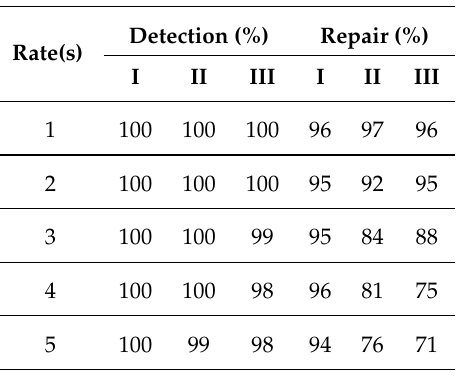
Table 4. The results of detected and corrected of the cycle slip over all stations for the three different methods in case 2.